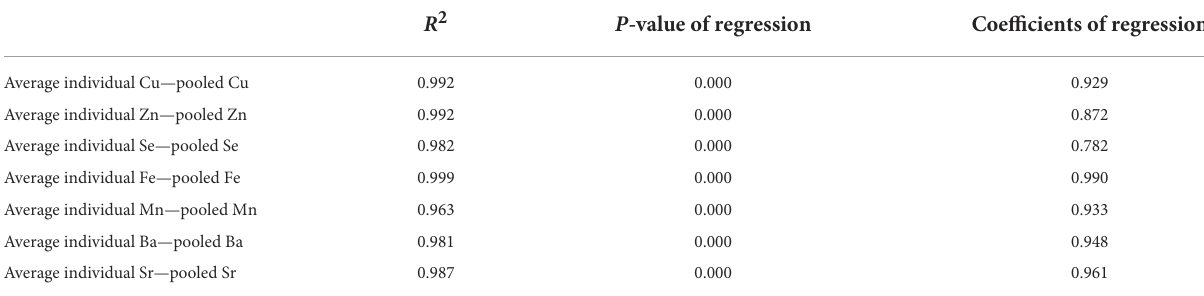
TABLE 3 Linear regression analysis for the essential and accidental trace elements in individual and pooled samples.